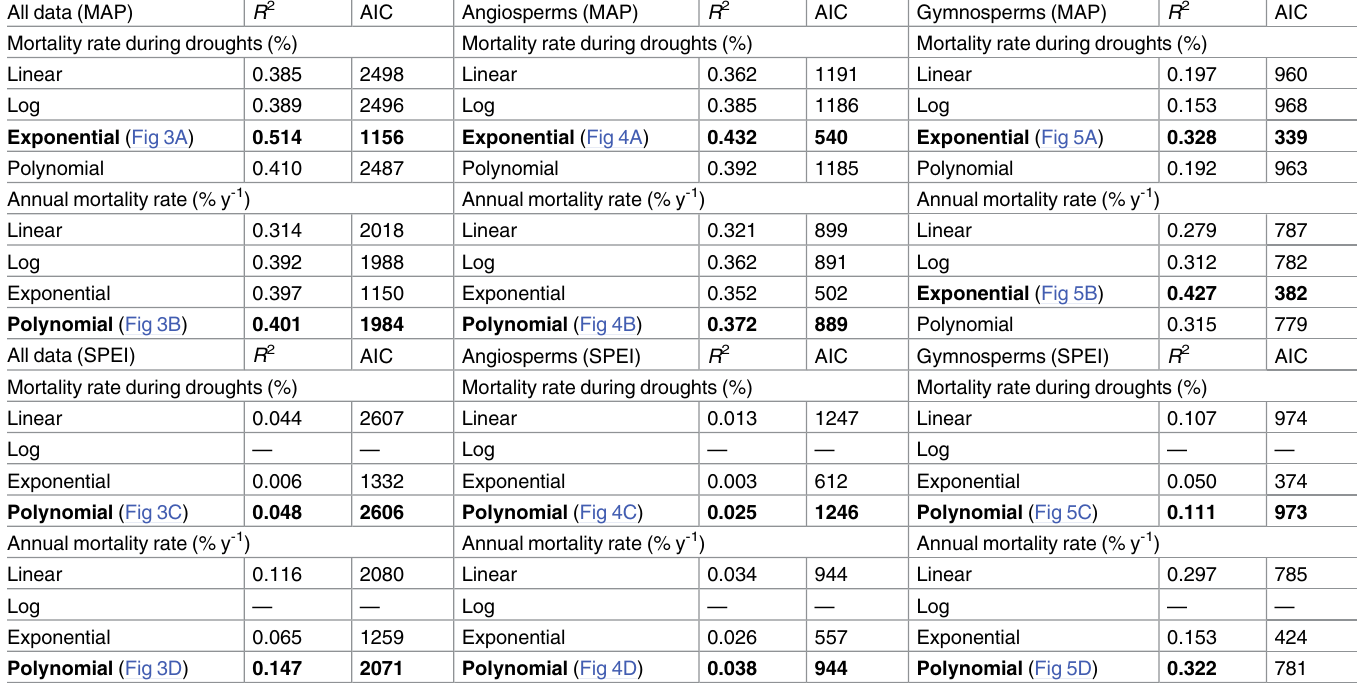
Table 4. Model fits for the global response of tree mortality to drought. Data sets variedwith tree group (angiosperm and gymnosperm), tree mortality metric (annualmortality rate (% y -1 ) and mortality rate duringdroughts (%)), and drought metric (MAP and SPEI). Best-fit models are highlightedin bold and are displayedgraphicallyin Figs 3, 4 and 5. For polynomial models, we fitted all possibletwo- and three-factor models and only selecteda model with cubic terms when it had an AIC lower than all other models and an R 2 higherthan all other models. MAP, mean annualprecipitation; SPEI, standardized precipita- tion-evapotranspirationindex; AIC, Akaike’s information